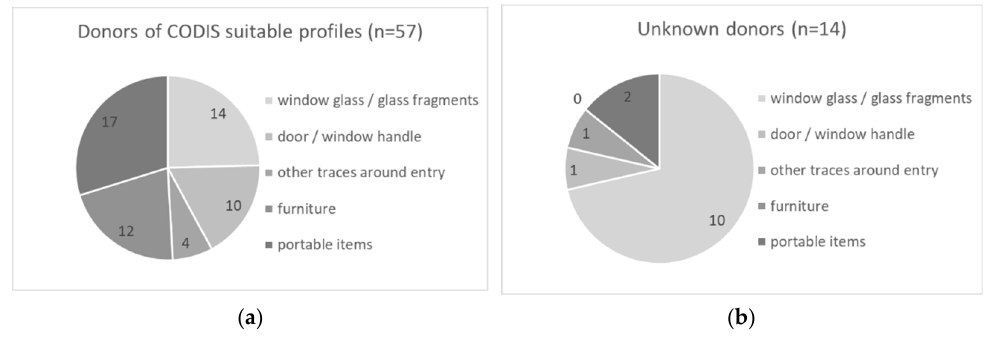
Figure 5. ( a ) Donors of the 48 CODIS-suitable profiles, according to trace class. ( b ) Unknown donors according to trace class. There were 0 unknown donors on furniture.